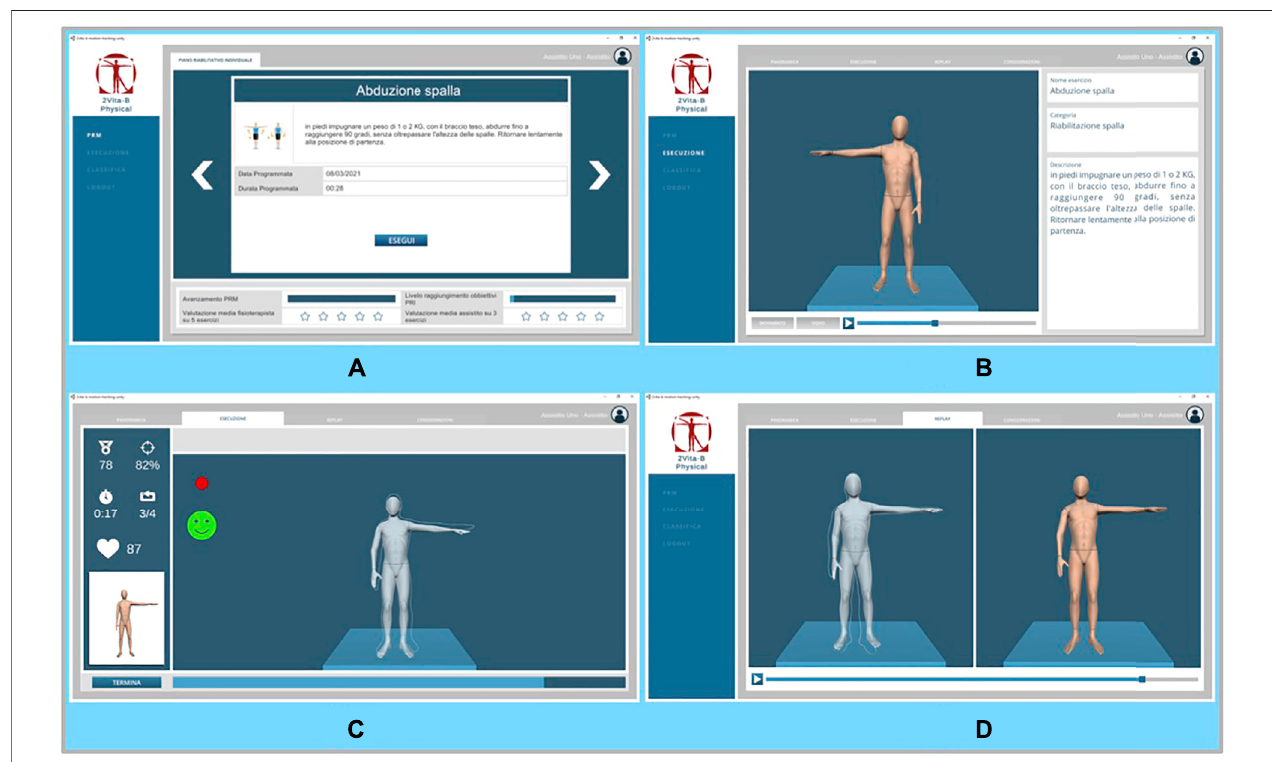
FIGURE 4 | The GUI of the Rehab Station: (A) list of exercise scheduled according to the motor rehabilitation plan; (B) detailed description of the exercise to be performed; (C) execution of an exercise; (D) replay of a performed exercise.